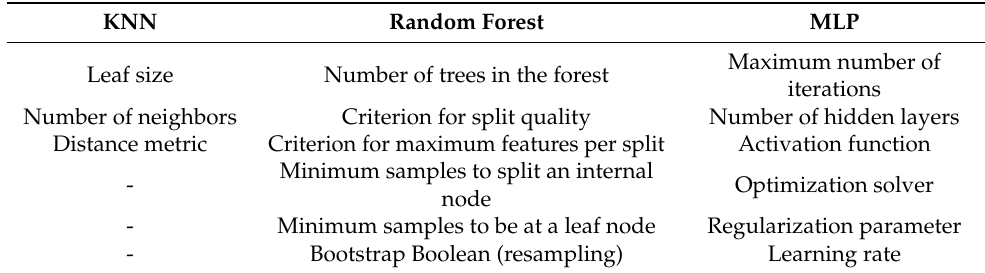
Table 5. Selected hyperparameters for grid search and cross-validation procedures.